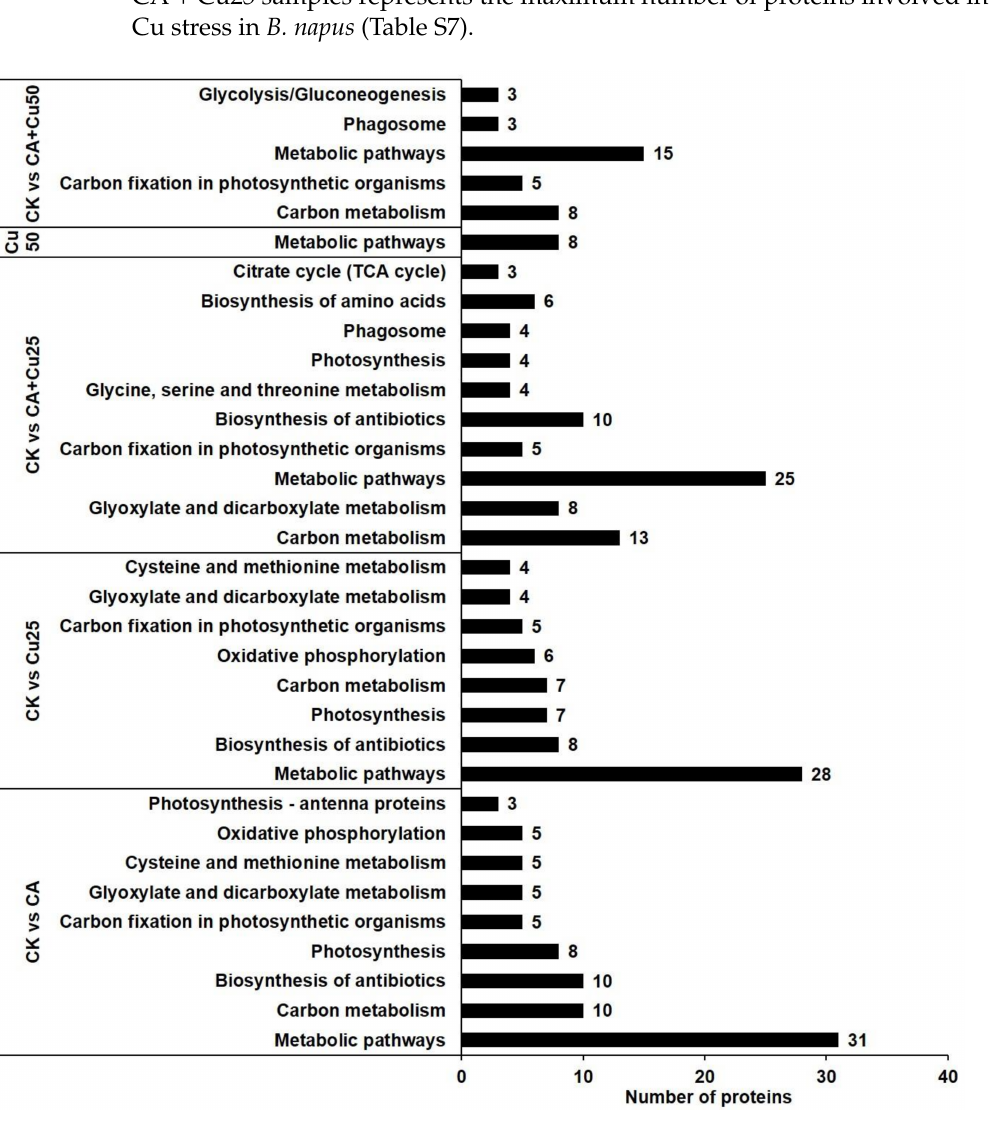
Figure 6. Top enriched KEGG pathways for DAPs identified in B. napus seedlings in response to CA-mediated Cu stress using DAVID